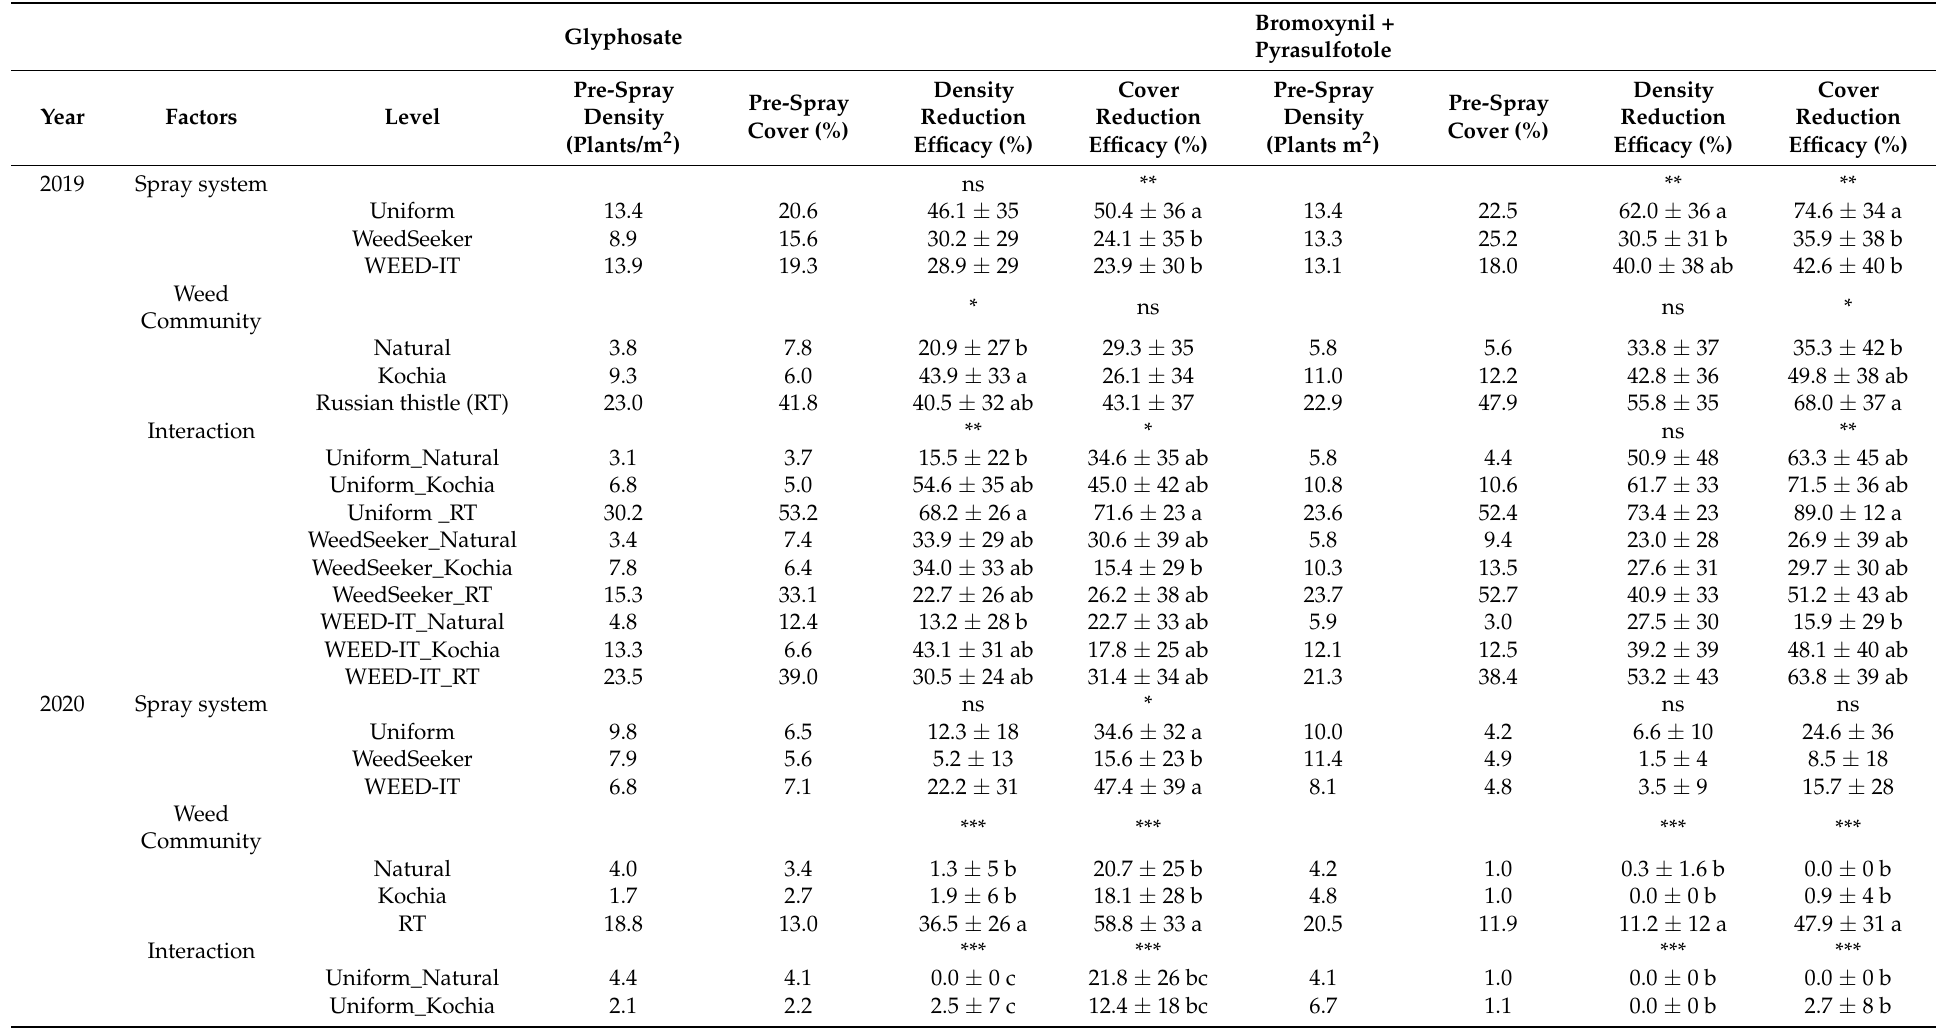
Table 3. Pre-spray weed density and cover, and herbicide control efficacy (mean ± SD) for plant density and cover in the postharvest trial for glyphosate and bromoxynil + pyrasulfotole herbicides in 2019 and